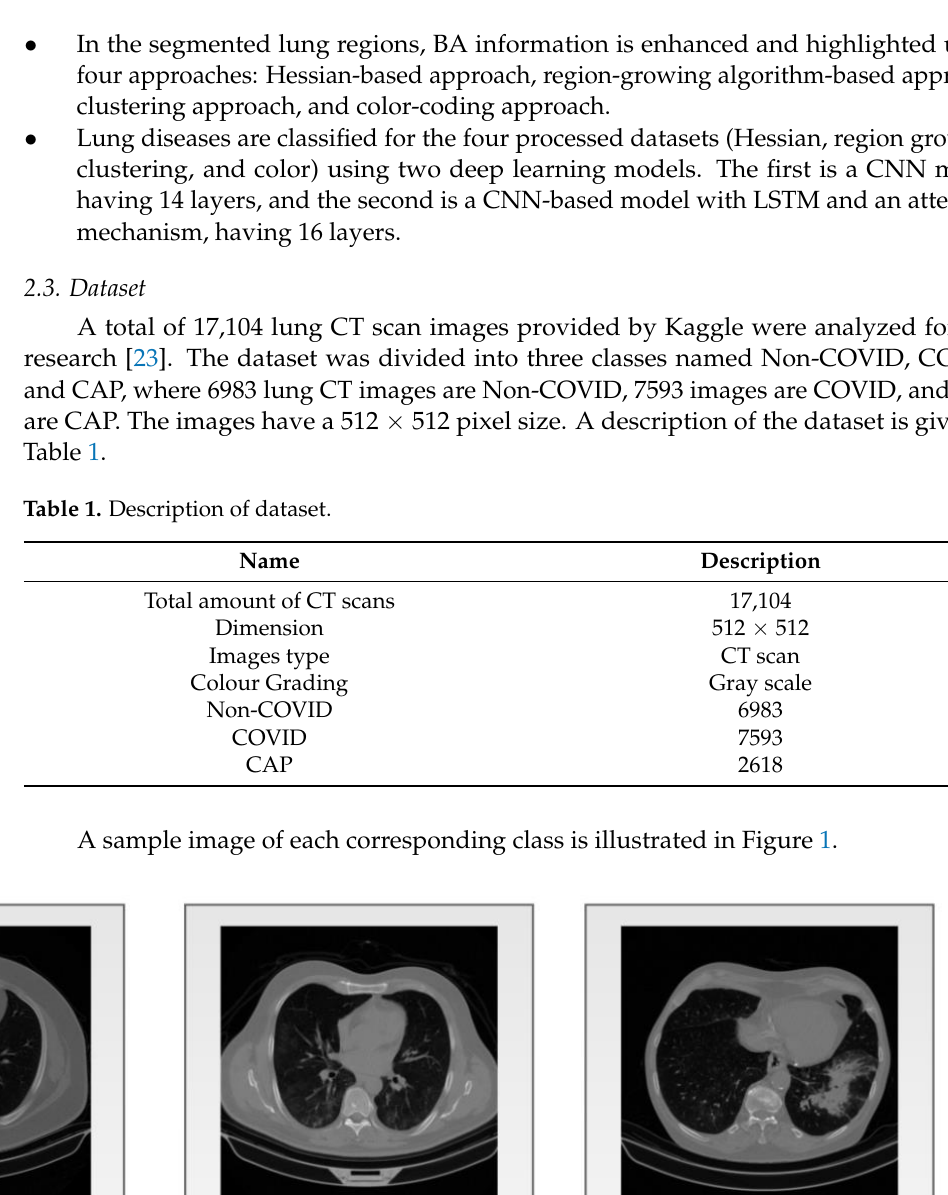
Table 1. Description of dataset.